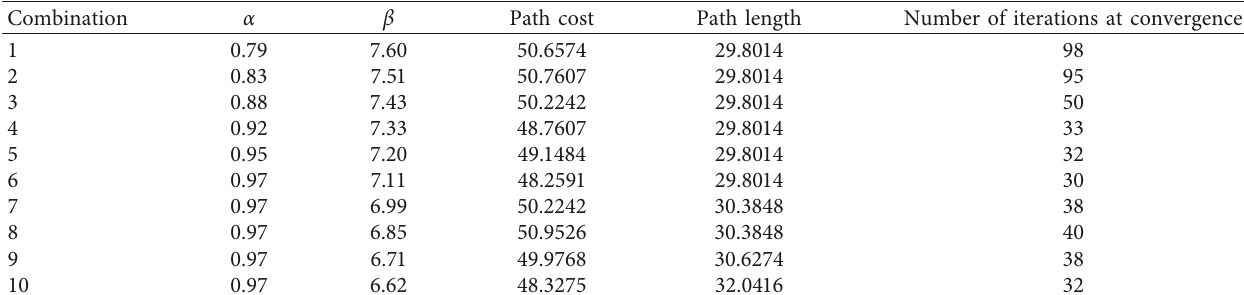
Table 4: Influence of different α and β combinations on the maximum and minimum ant colony